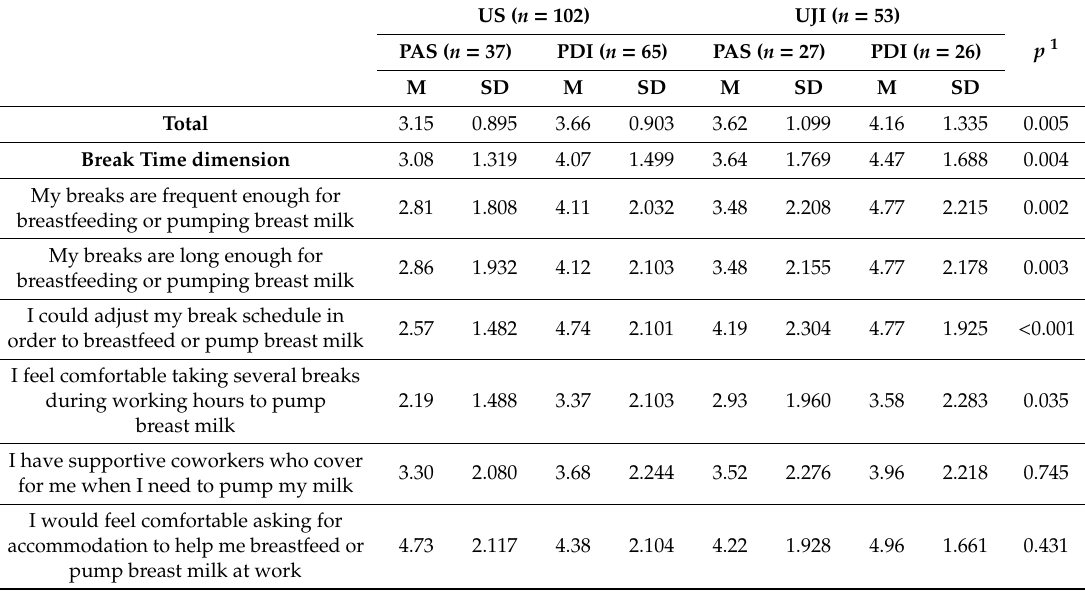
Table 5. Results obtained with the Workplace Breastfeeding Support Scale. Comparison of occupational situation at universities ( n =